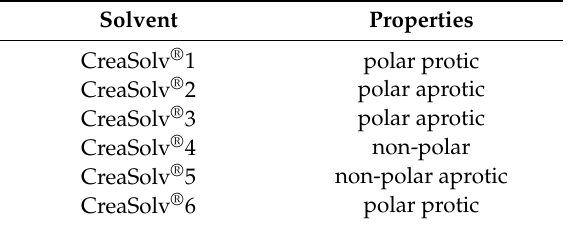
Table 1. Overview of the applied CreaSolv ®